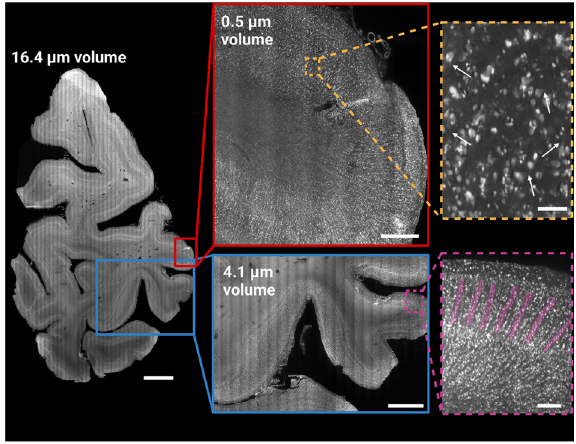
Fig. 4 Multi-scale imaging of human brain tissue. Data acquired from the entire occipital lobe slice (third 3 mm thick section from occipital pole towards anterior direction) shown at 16.4 µ m resolution (16.4 µ m volume; left side). Two gyri were imaged at a resolution of 4.1 µ m (blue), and in the 0.5 µ m volume (red) at an anisotropic resolution, with a pixel size of 0.725 µ m × 0.5127 µ m × 0.5127 µ m. The magni fi ed inserts demonstrate the effective resolution achievable with the 4.1 µ m volume (magenta) and 0.5 µ m volume (orange), respectively. While the 4.1 µ m volume shows mesoscopic structures indicative of minicolumns (highlighted in magenta), it can be dif fi cult to differentiate smaller individual cells from cell clusters at this resolution in the extremely densely populated koniocellular visual cortex. The 0.5 µ m volume allows for the identi fi cation of single cells, including the proximal parts of apical and basal dendrites (white arrows).